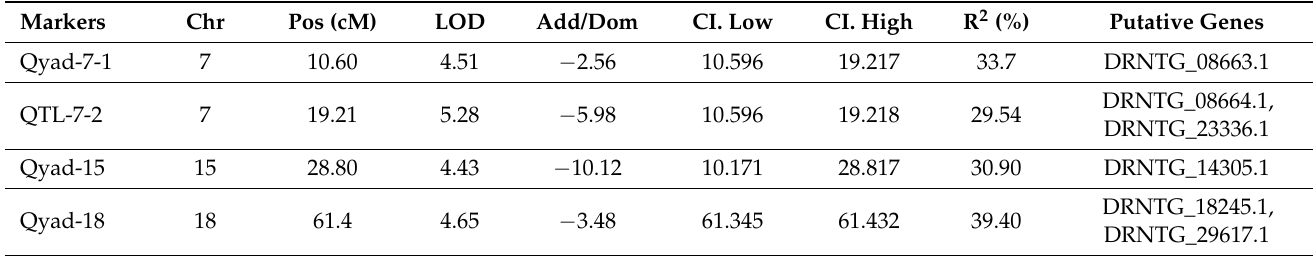
Table 3. Summary of significant QTLs detected for yam anthracnose disease resistance in water